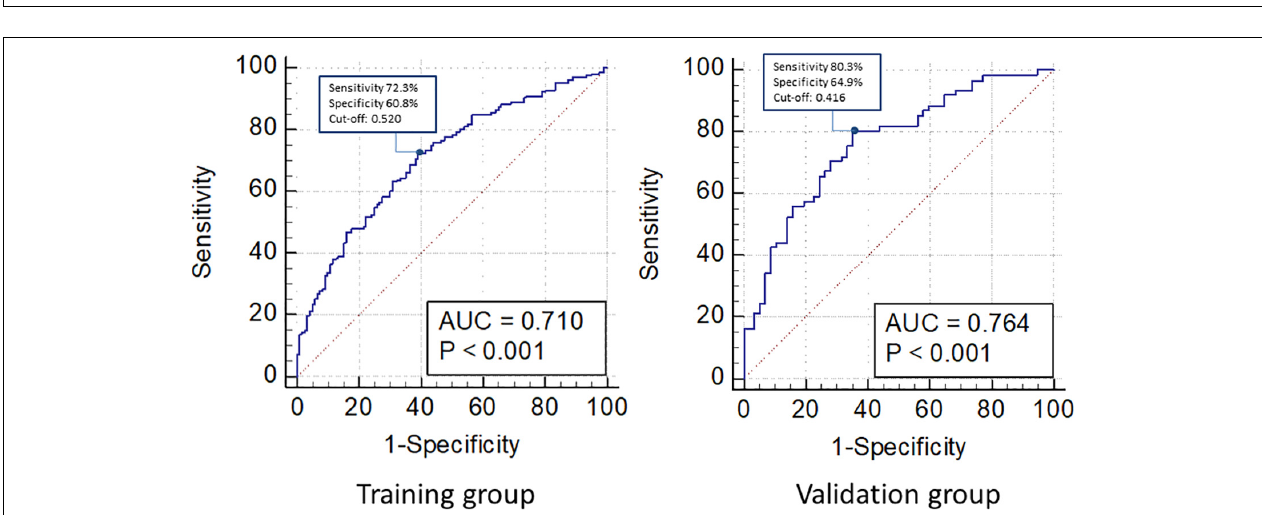
FIGURE 3 | Nomogram of individualized prediction model to predict 3-month poor functional outcome. The nomogram was composed of two areas, the upper area was designed to calculate the total score as the sum of scores for ln(NT-proBNP), National Institutes of Health Stroke Scale (NIHSS), and glucose. The lower area was designed to get the probability of patients to get a poor functional outcome.